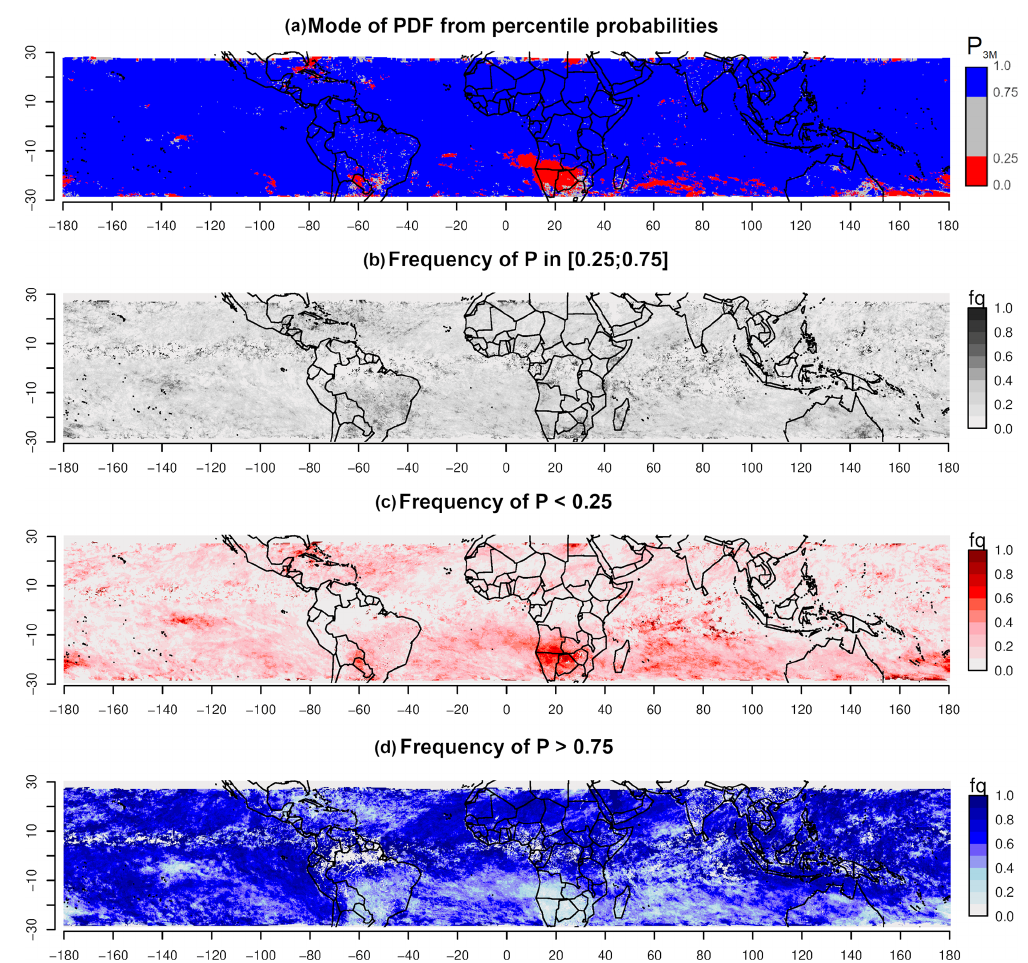
Figure 9. Maps of the probabilistic method for the layer 400–600hPa applied over the period from April to June 2018. (a) Mode P 3M and frequencies of single-time-step P within (b) the middle half (0.25 ≤ P ≤ 0.75), (c) lower quarter ( P < 0.25) and (d) upper quarter ( P > 0.75) of the distribution of